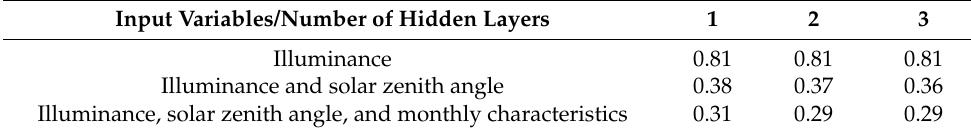
Table 2. Pearson’s correlation between the monthly average illuminances and the UVI